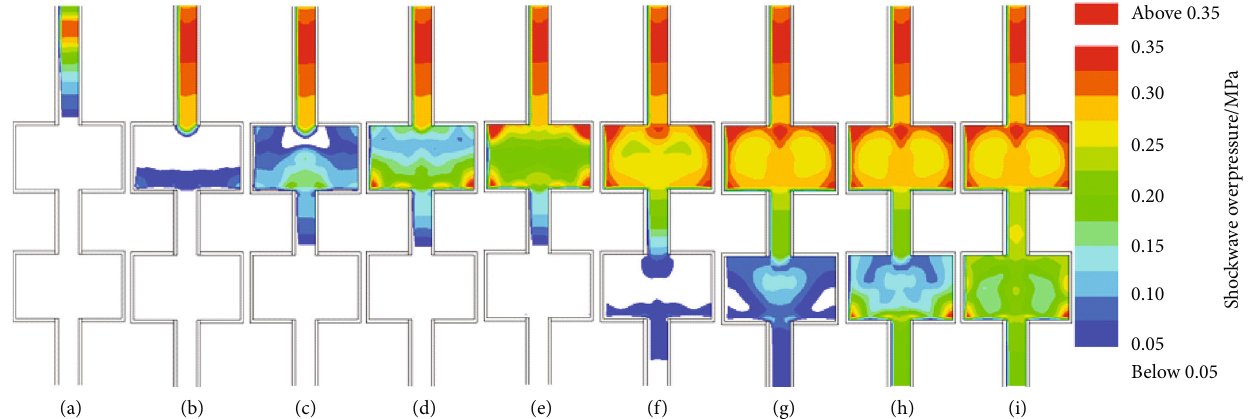
Figure 9: The propagation process of gas explosion shock wave in the dual